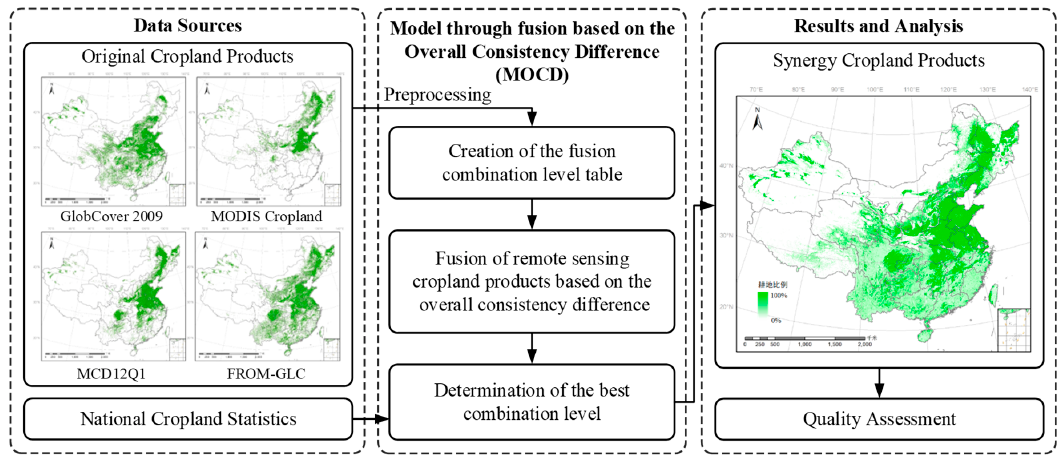
Figure 2. Flowchart of the proposed model.